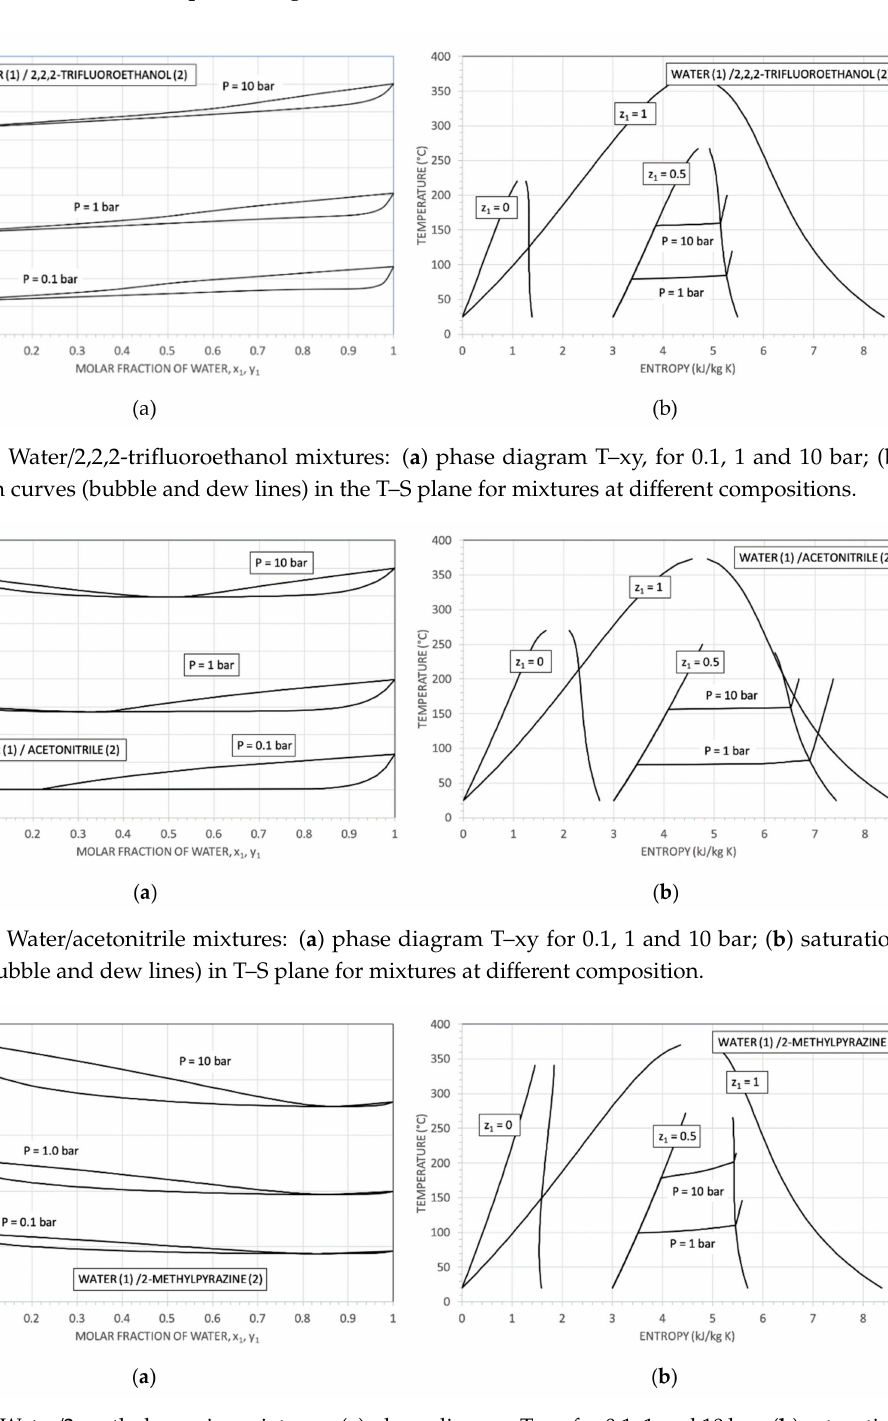
Figure 5. Water / 2-methylpyrazine mixtures: ( a ) phase diagram T–xy for 0.1, 1 and 10 bar; ( b ) saturation curves (bubble and dew lines) in T–S plane for mixtures at di ff erent